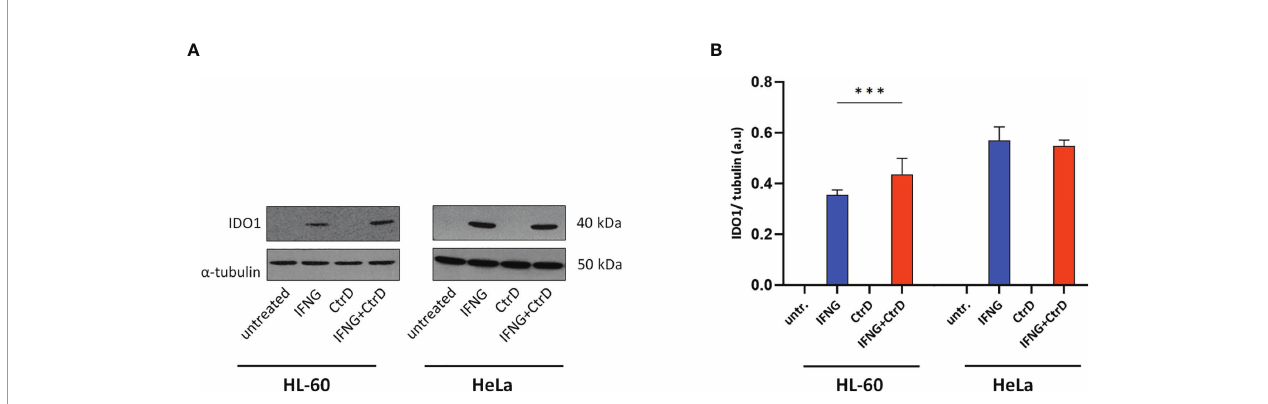
FIGURE 4 | IDO1 expression in HL-60 and HeLa cells. Cells were infected with Chlamydia trachomatis (multiplicity of infection, 4) and were treated with 20 IU/ml interferon-gamma or left untreated. (A) Western blot was performed at 24 h post-infection. A representative Western blot is shown. (B) Western blot band intensities were quanti fi ed, and IDO1 expressions were normalized by a -tubulin expression. The normalized intensities in each cell type were compared by one-way ANOVA, with correction for multiple testing. Data are mean±SD ( n = 3 – 4). *** P < 0.001.